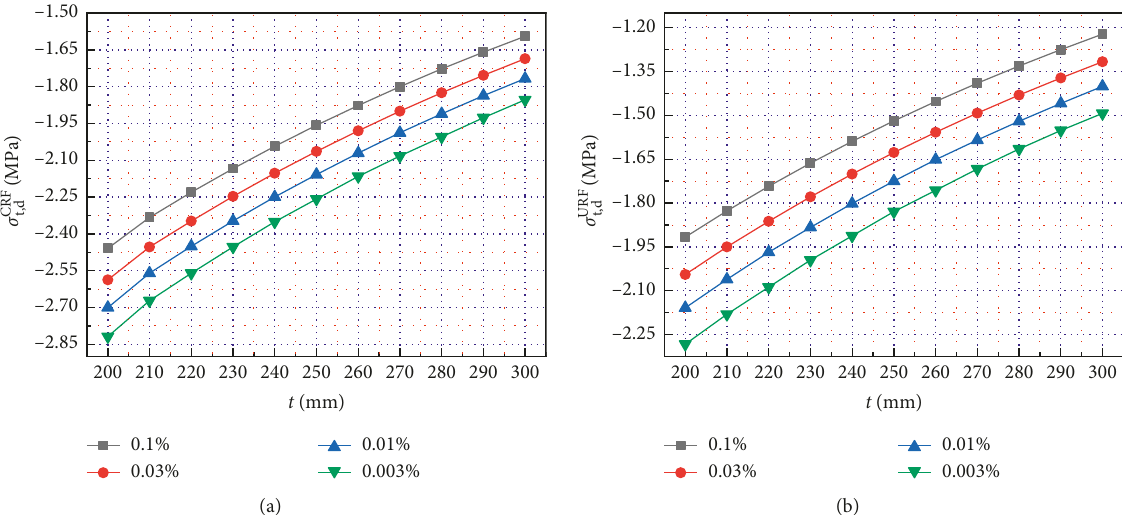
Figure 17: The relationship between the designed tensile strength and liner thickness under different random fields for different target probabilities of failure: (a) CRF and (b)